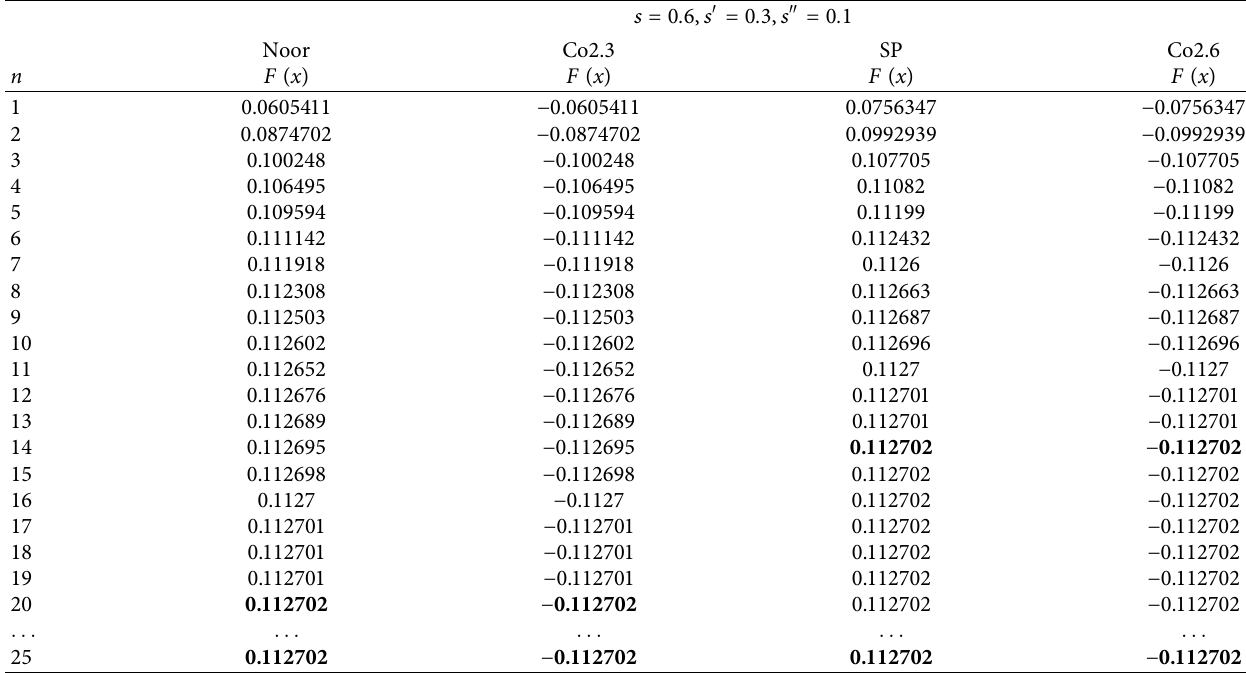
Table 1: Iterations of quadratic function s � 0 . 6 ,s ′ � 0 . 3 ,s ″ � 0 .